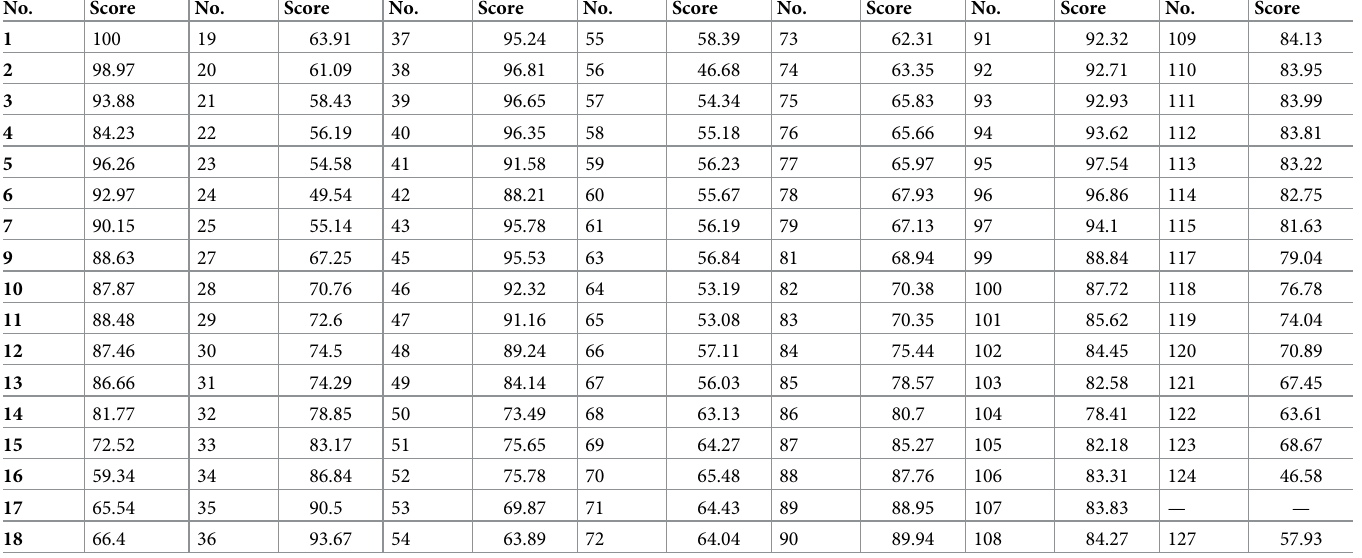
Table 1. Scores of sampling points on the unevaluated